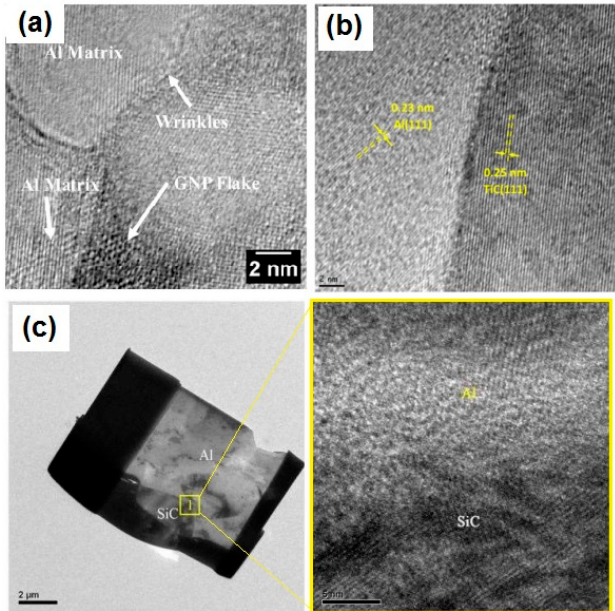
Figure 10. Coherent and semi-coherent interfaces between the matrix and reinforcing particles: ( a ) TEM-BF images of FSPed A356 reinforced with graphene nanoplatelets (GNP) showing the interface between the matrix and encapsulated GNP flakes (reproduced from [136], with permission from Elsevier, 2020); ( b ) HRTEM micrograph of the particle/matrix interface in the six-pass FSPed composite (reproduced from [79], with permission from Elsevier,2019); ( c ) HRTEM micrographs of the stir zone containing bare SiC reinforcement (reproduced from [60], with permission from authors, 2018).